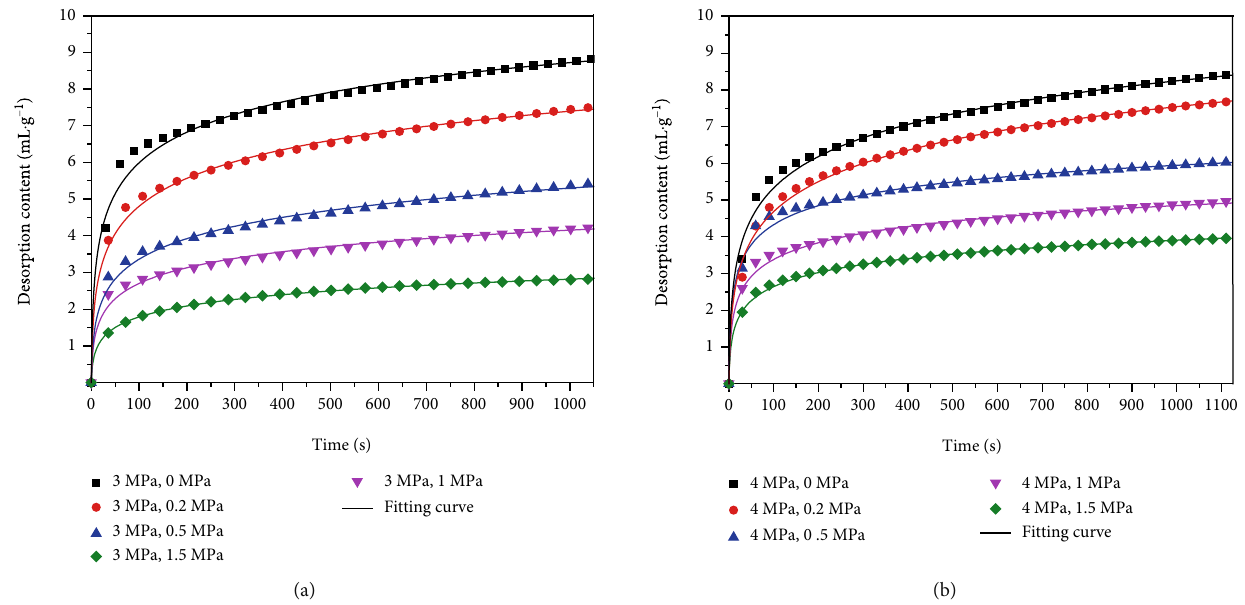
Figure 4: Relationship between the desorption content and time under di ff erent positive pressures: (a) Sihe sample and (b) Canghai sample.